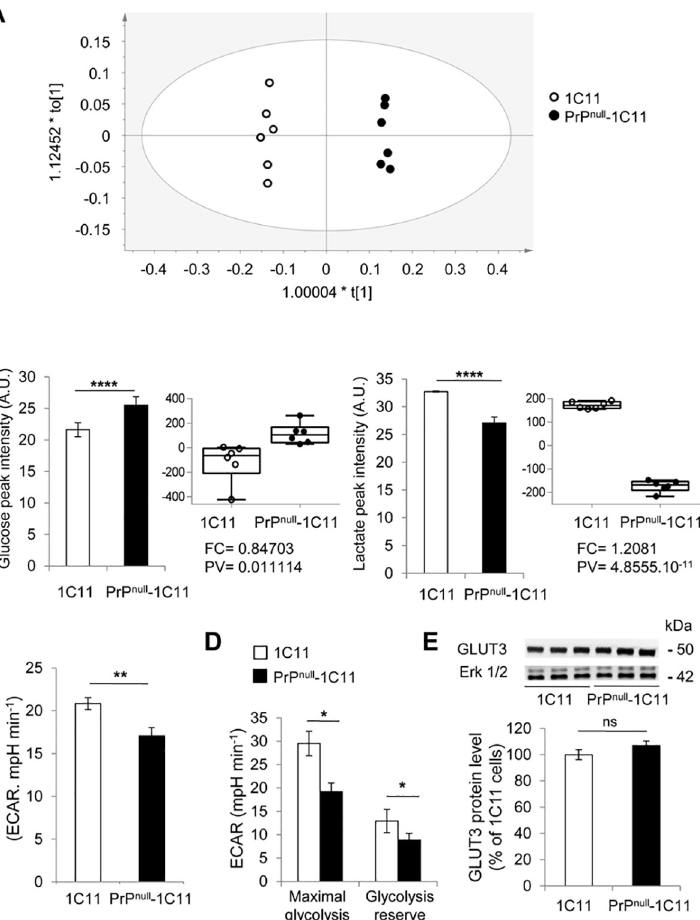
Fig 2. Loss of PrP C causes reduction of the glycolytic flux. ( A ) The NMR analysis of metabolites present in the cell culture medium of PrP null - and 1C11 cells (n = 6) grown for four days in DMEM-Glutamax-FCS with 25 mM glucose. The OPLS-DA model shows that the PrP null -1C11 cells group is distinct from that of 1C11 cells according to the predictive axis t[1]. The orthogonal axis to t[1] is the uncorrelated variables axis. A p-value (CV-ANOVA) = 9.82218 10 − 8 , R 2 X(cum) = 0.872, R 2 Y(cum) = 0.996, and Q 2 (cum) = 0.994 reflect the good quality of the model. ( B ) NMR- derived histograms and boxplots of external concentrations of glucose and lactate in the cell culture medium of PrP null - and 1C11 cells (n = 6) grown for four days in DMEM-Glutamax-FCS with 25 mM glucose. Buckets at 4.12 ppm and 3.2 ppm correspond to lactate and glucose, respectively. Histograms show glucose and lactate peak intensities (in arbitrary units—A.U.). Boxplots show normalized concentrations of glucose and lactate. The fold-change (FC) and p- values (PV) are indicated on each boxplot. ( C ) Extracellular medium acidification rate (ECAR) in 1C11 and PrP null - 1C11 cells measured by Seahorse XF e 96 Extracellular Flux Analyzer. Seahorse experiments were run with the assay medium containing 25 mM glucose and Glutamax 1X. Data represent the average of 6 replicates ± SEM. ( D ) Maximal glycolysis (ECAR after inhibition of mitochondrial ATP synthase activity with oligomycin 10 mg ml -1 ) and glycolytic reserve (= maximal ECAR—basal ECAR) in PrP null - vs . 1C11 cells grown as in C (n = 10). ( E ) Western blot (cropped image) and histogram quantification for GLUT3 protein expression in PrP null - vs . 1C11 cells. ERK1/2 MAP kinases were used for normalization (n = 7). Data are mean fold change ± SEM. � denotes p < 0.05, �� p < 0.01, ��� p < 0.001, and ���� p <